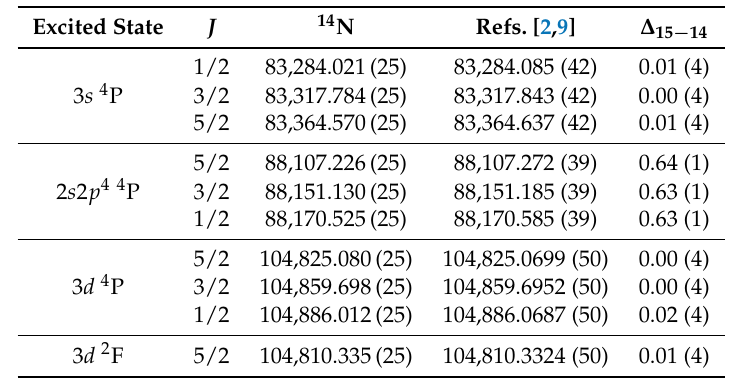
Measured transition frequencies for N I and isotopic shifts for lines excited from